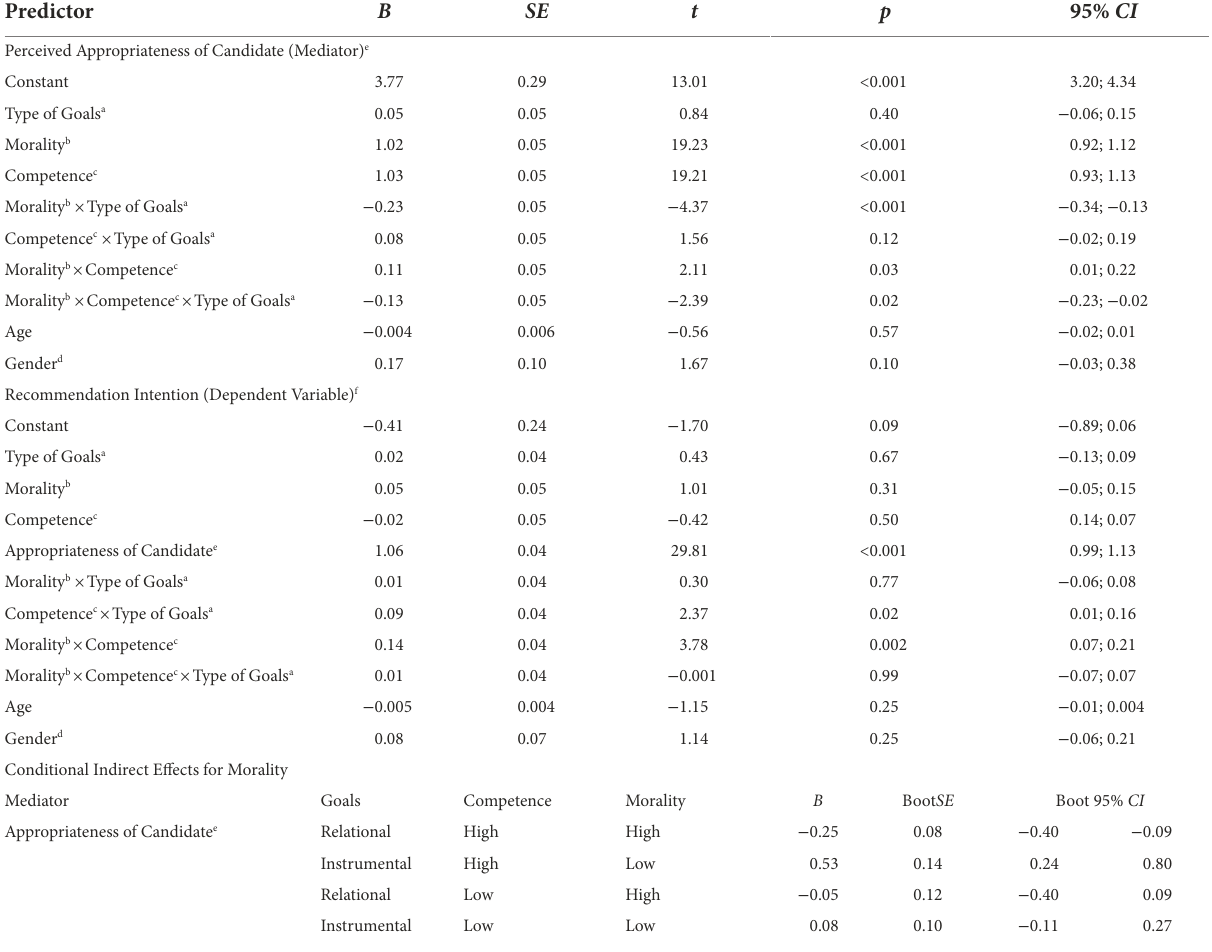
TABLE 4 Regression analysis results on the effect of morality and competence on perceived appropriateness of a candidate and recommendation for recruitment as a function of type of goals (Study 3).